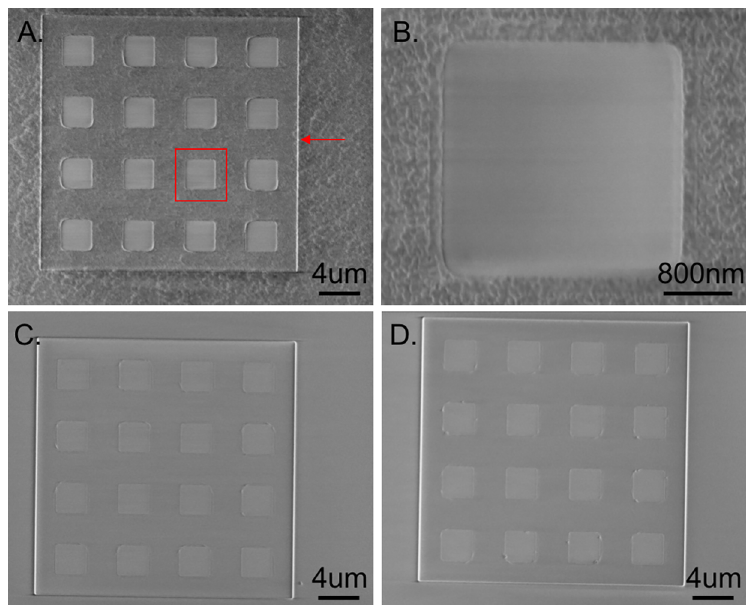
Fig 2. Germanium dissolution. A) SEM image of 50 nm Ge films deposited by LPCVD before dissolution. Red arrow indicates the edge of a 25 μ m by 25 μ m square well, etched 500nm deep. B) Higher magnification of red box in A). C&D) SEM images of Ge layers after 10min C) and overnight D) incubation in 0.35% H 2 O 2 at room temperature. Ge was completely dissolved in 10min with no residues left. Faint square outlines are due to the over-etch process in the Ge etching recipe and thus the adhesive amorphous Si layer between Ge and HTO is etched away.